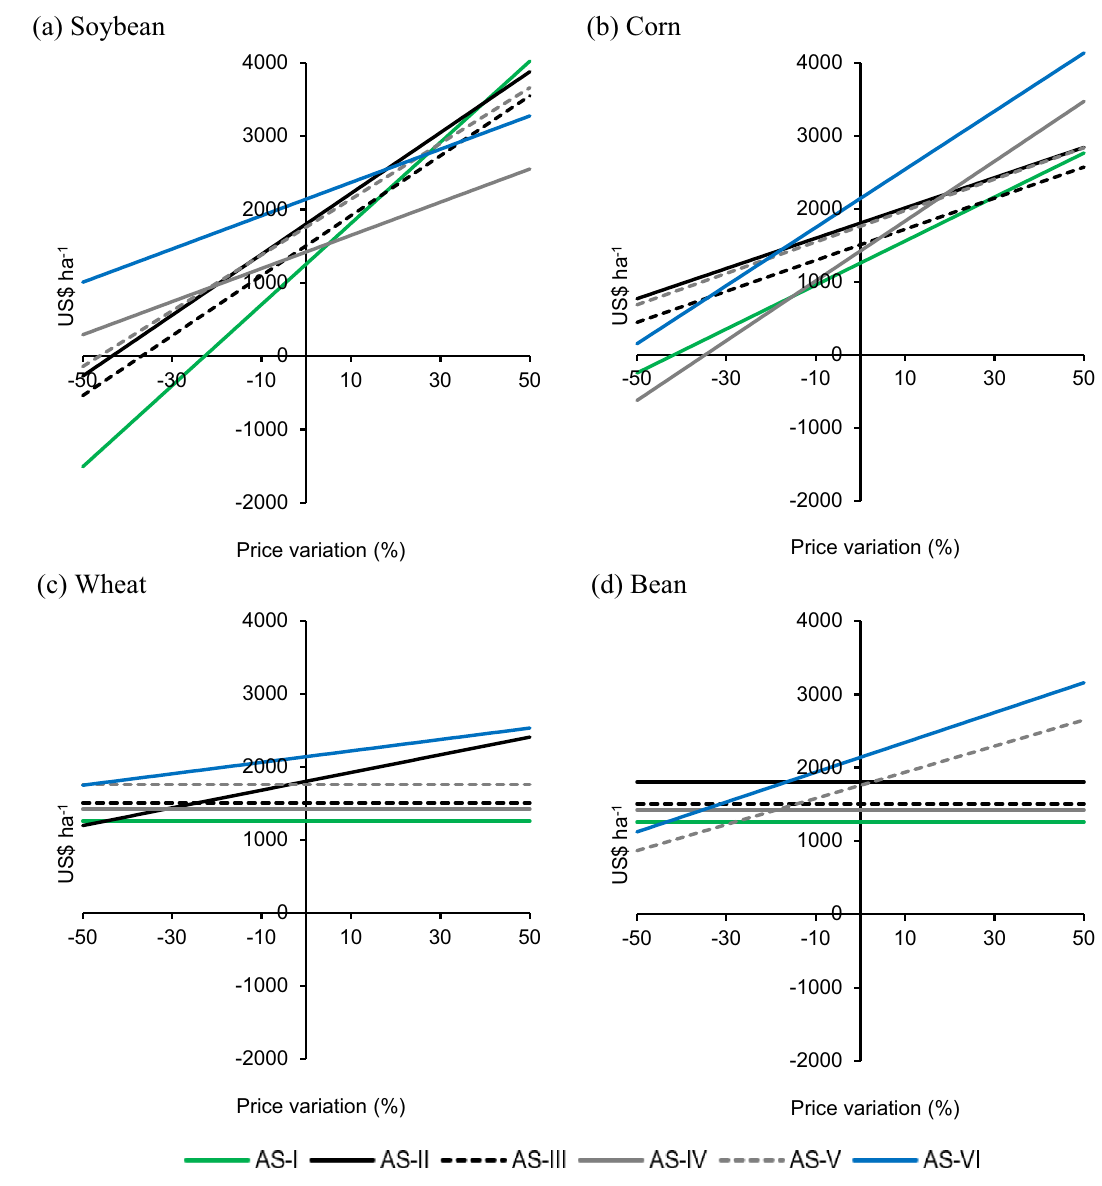
Figure 3. Price sensitivity analysis (accumulated profit of 6 crop years on the y-axis) of six agricultural systems in Londrina, state of Paraná, Brazil. ( a ) Soybean; ( b ) corn; ( c ) wheat; and ( d )